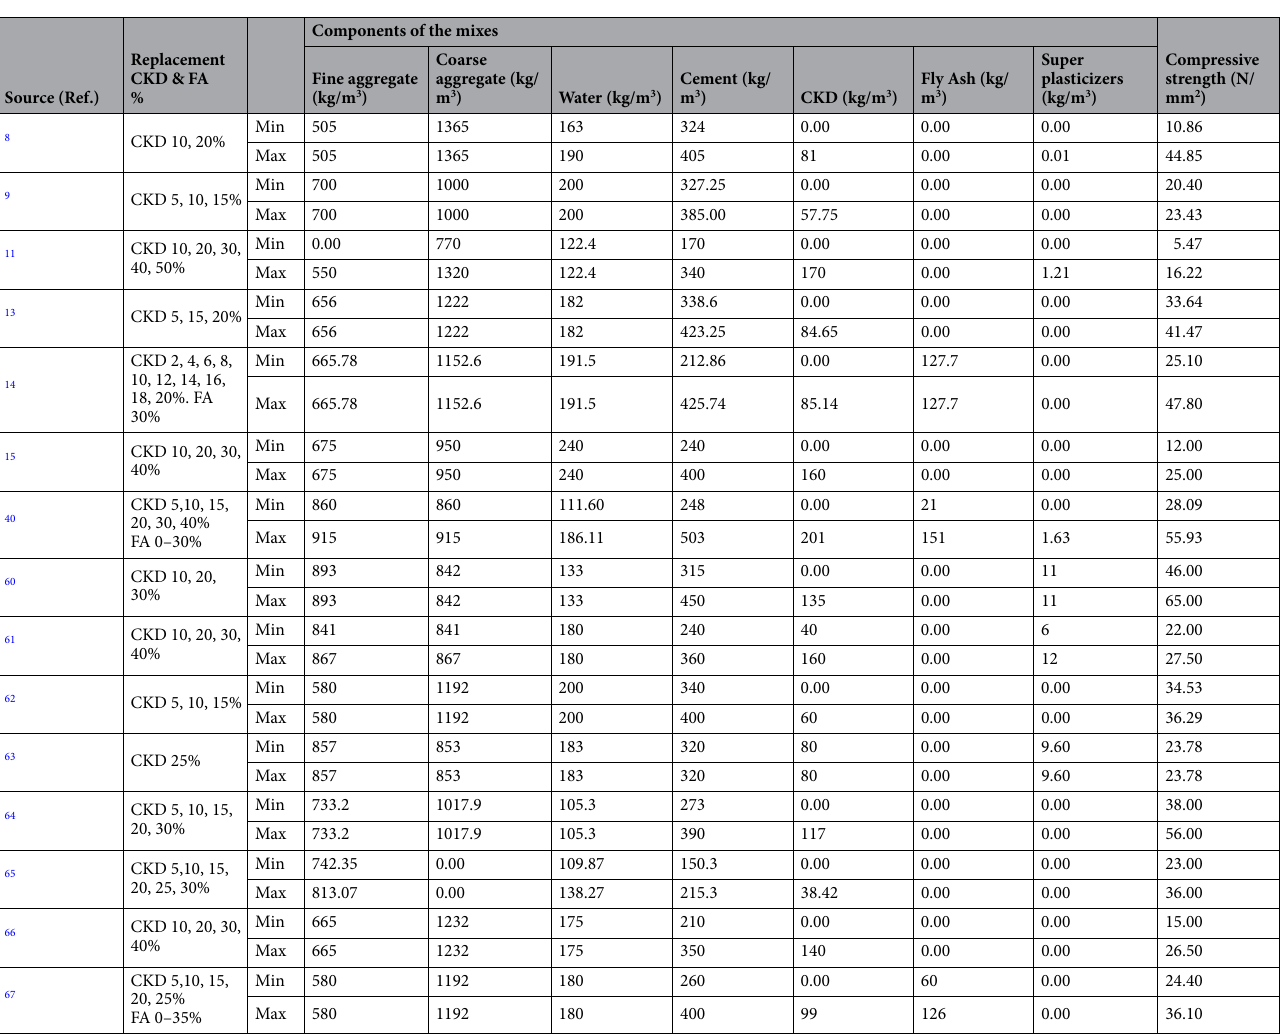
Table 1. Data collection for green concrete incorporating CKD and